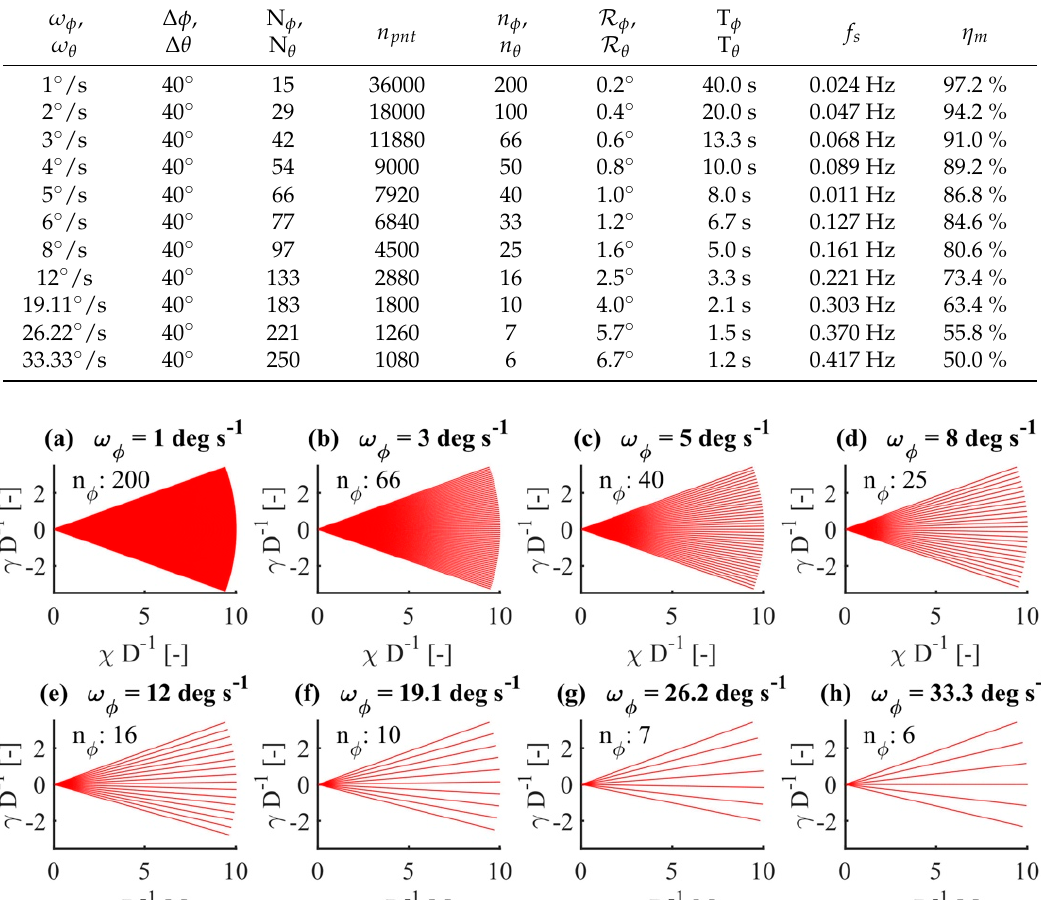
With the simulated measurement trajectories, we aimed to reproduce measurement points that are comparable to those in the measurement campaign and maintain the radial resolution of 7 m. The related choices result in an overlap of the pulses emitted by the LiDAR as 81.3% of the probe volume length of ~60 m. This resulted in the total number of radial ranges ( 𝑛 (cid:3045) ) being 180 at the radial distances of 1 to 1260 m. The point density of the Cartesian LES and the polar LiDAR measurement grid differ in the 𝜒 direction because of the radial spread of the angular measurements, which is illustrated in Figure 2. Thus, numerical redundancies while interpolating within LES grid cells can only be prevented with an extremely finely discretised wind field and the necessary numerical and temporal capacities were not available within the scope of this study. Since the spatial resolution of the LES with 10 m per grid cell is coarser than the 7-m radial resolution of the LiDAR simulation, the permanent interpolation of the LES grid onto the LiDAR grid restricts our results to realistic behaviours. We expect that the standard deviation of the simulated LiDAR measurement will be